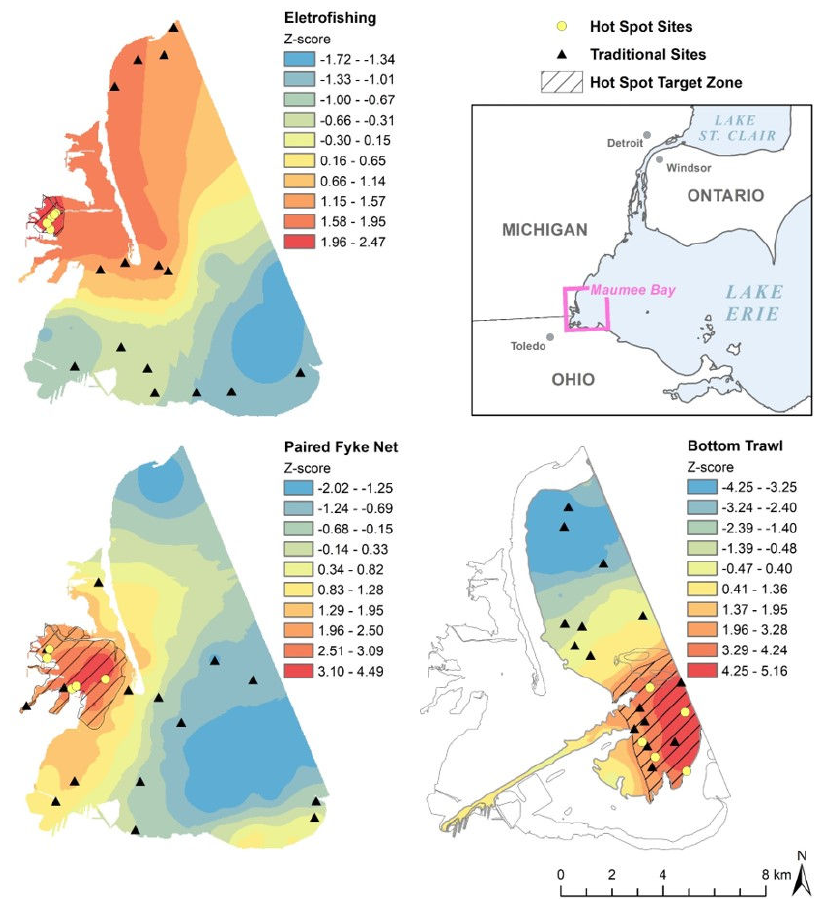
Figure 1. Maumee Bay showing 2017 sampling sites (both traditional and hot spot) by gear type and gradients of interpolated fish species richness z-scores from the hot spot analysis using randomly sampled data from 20132016 (see Section 2.3). Warm colors indicate higher species richness and cool colors indicate areas with lower species richness. The bottom trawl interpolated surface in the bottom right is within the 2 m or greater depth contour. The hot spot target zone, black diagonal lines, contains z-scores ≥ 1.96.